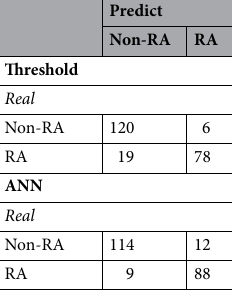
Table 3. Confusion matrix of threshold method and ANN method.